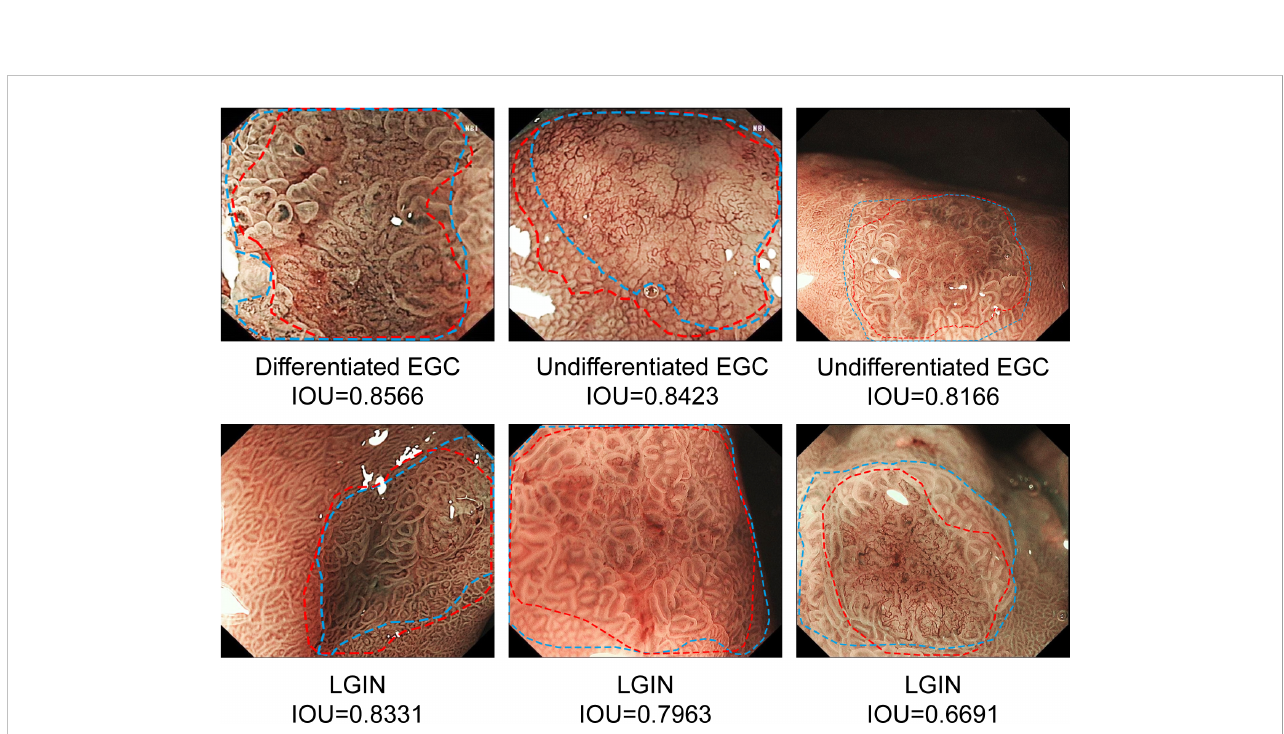
FIGURE 7 Examples of segmentation performance of CNN2 in the test sets. The margins of the neoplastic lesions labelled by an expert endoscopist are shown as blue lines, and the margins of the lesions predicted by CNN2 are shown as red lines. CNN, convolutional neural